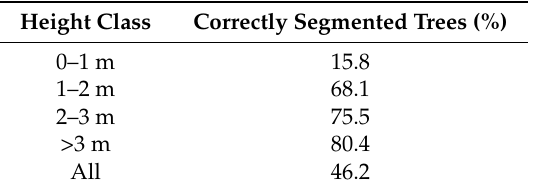
Figure 7. Visualization of single-tree segments and ALS echoes from ALS2012, covering the same area as Figure 2. Viewed from above ( upper figure ) and from the side ( lower figure ). The segments extent and estimated tree heights are colored green, and the ALS echoes are colored from grey to black. The highest echoes are colored black. Note that the terrain height has been subtracted from the ALS echo heights (see Section 2.3 for details).